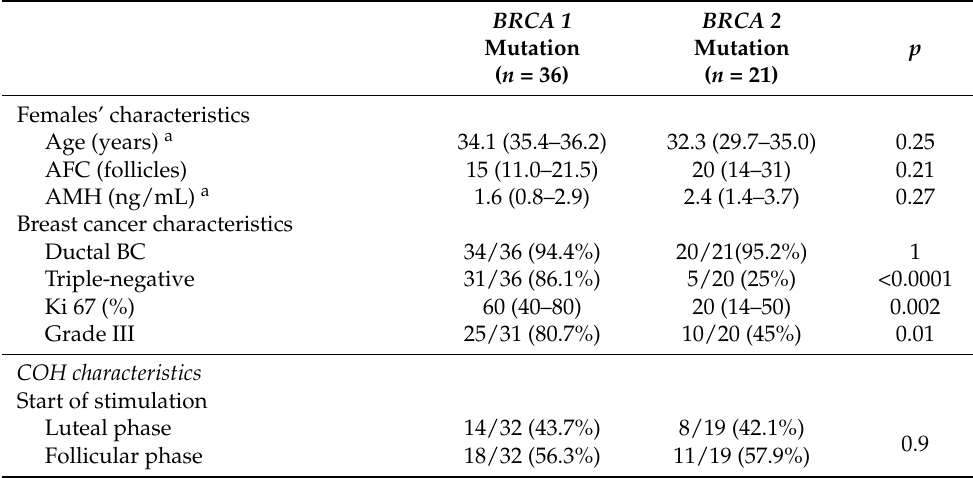
Table 3. Females, breast cancer, COH characteristics and outcomes according to the type of BRCA pathogenic